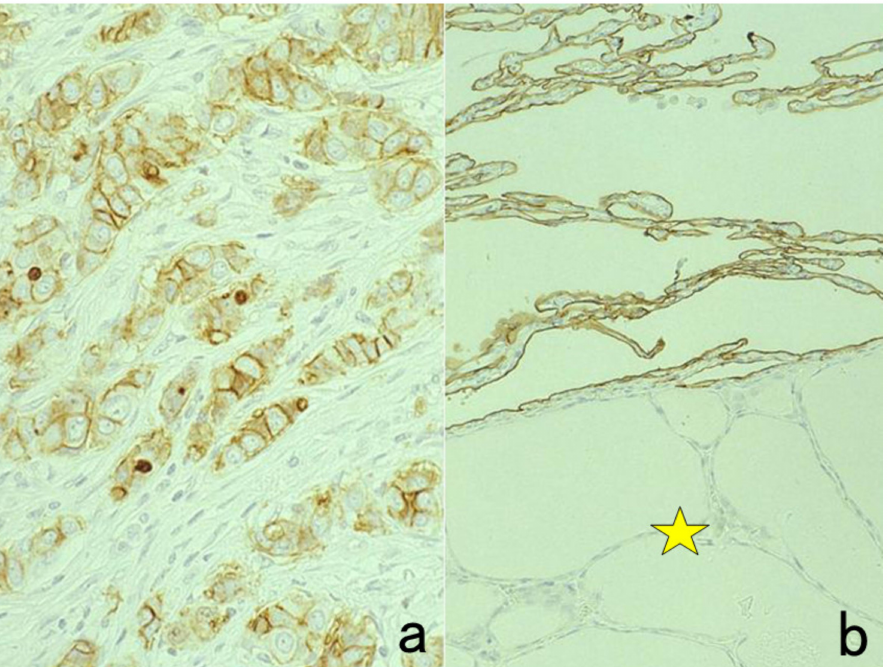
Figure 46. Plasma membrane localization of Ki-67. ( a ): Breast cancer and ( b ): lung with ectopic thyroid tissue. Ki-67 may show strange, cross-reactive localization on the plasma membrane. Mem- branous positivity in invasive ductal carcinoma cells and alveolar type I pneumocytes is unique but nonspecific. The star indicates ectopic thyroid tissue in the lung.